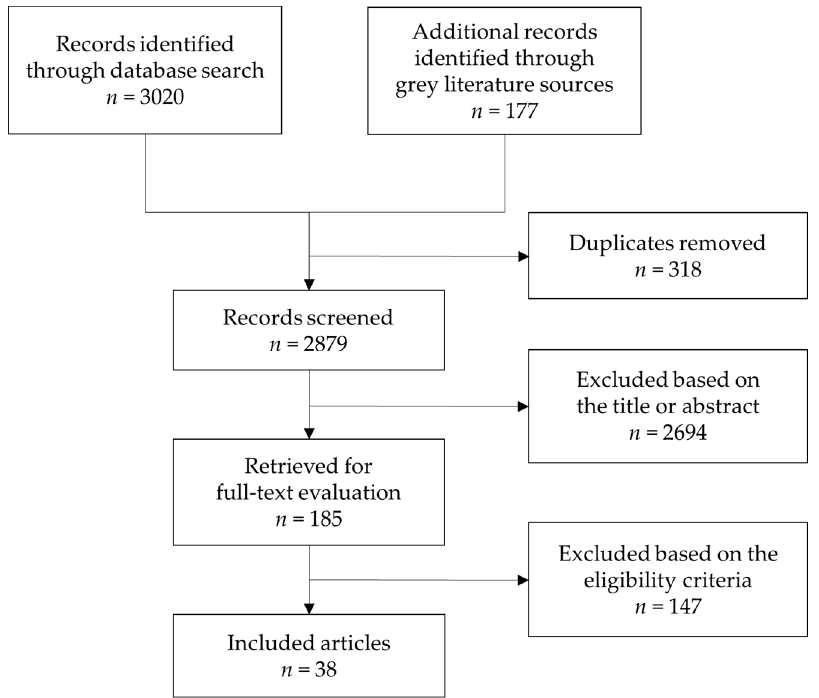
Figure 1. Preferred Reporting Items for Systematic Reviews and Meta-Analyses (PRISMA) flow chart of the study selection process.